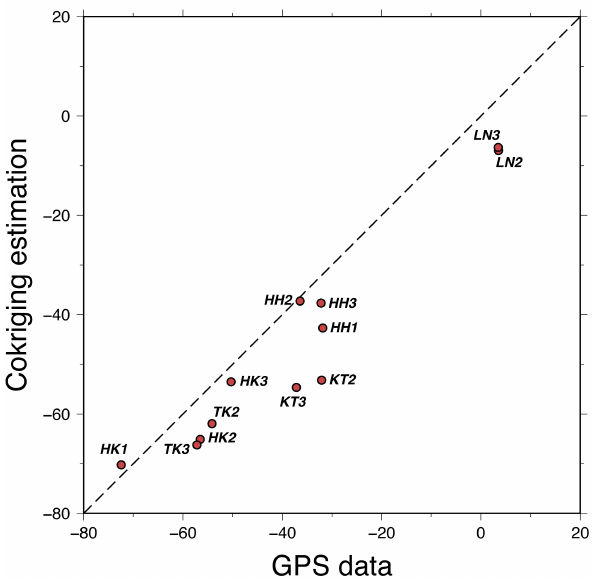
Figure 4. The comparison of cokriging estimation with GPS data. The code name of GPS station is written in